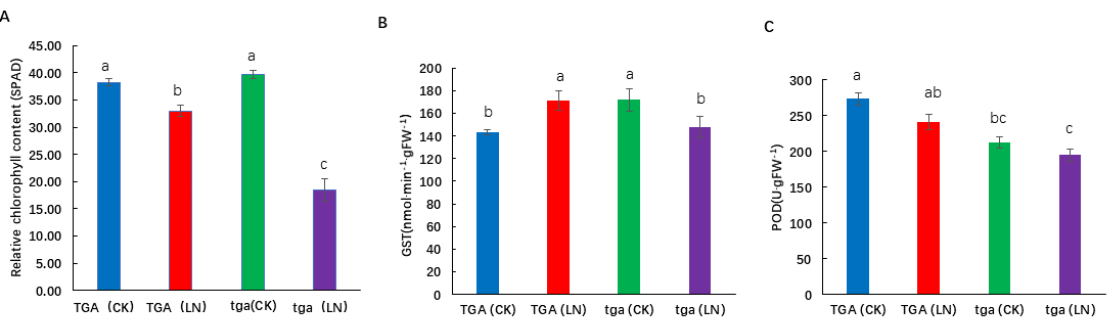
Figure 8. Physiological differences between wild-type TGA and mutant tga at two nitrogen levels. ( A ) Relative chlorophyll content (SPAD), ( B ) Glutathione S-transferase (GST) activity, ( C ) Peroxidase (POD) activity. Different letters indicate significant differences at p < 0.05 between different groups according to the Duncan test. CK, 4 mmol L − 1 ; LN, 0.04 mmol L − 1 NO 3 − .